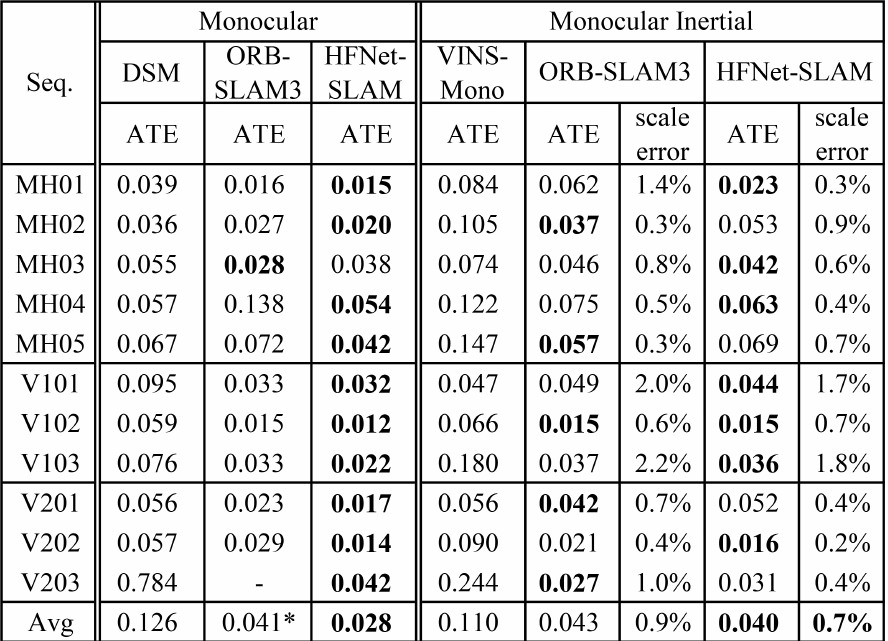
Figure 4. Comparison results in EuRoC dataset (rms ATE in meters; scale error in %). The results of HFNet-SLAM are median of ten executions. The measurements of other systems are provided by [1]. The bold values denote the smallest errors. Asterisks mark systems that did not complete all